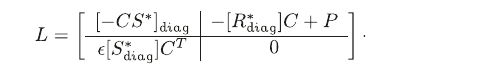
Fig. 2 Structural stability changes non-monotonically with species similarity. The volume of the set of mortality rates leading to feasible densities for the resources, R * , can decrease even when species similarity is decreased. Here, we show an example in three dimensions, where each axis represents one of the three mortality rates, μ i , and the volume is a kind of wedge extending from the origin outwards. The measure, V μ , of the size of this volume is then equivalent to the area (colored green or blue) of a triangle on the surface of the unit sphere, where the dissimilarity of each pair of species is proportional to the length of one of the triangle ’ s sides. On the left, this volume is shown for the particular 3 × 3 matrix C T detailed in our Methods section, and is colored green. When the angle between one pair of column vectors is increased while the other angles are unchanged, we get the volume shown on the right-hand side. The resulting volume decreases in size, despite the average similarity of these three species having which have a correspondingly more general Jacobian matrix